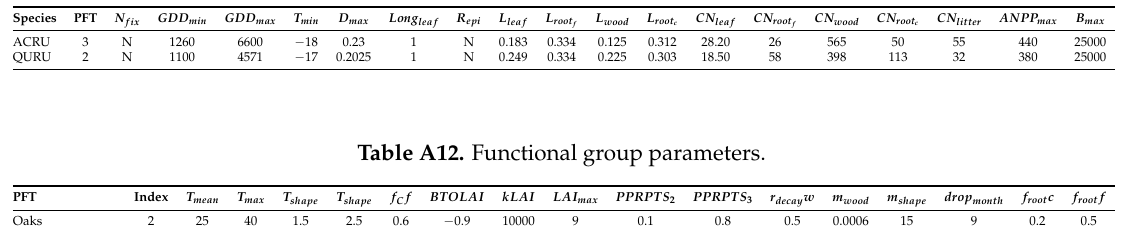
Table A11. NECN species parameters.